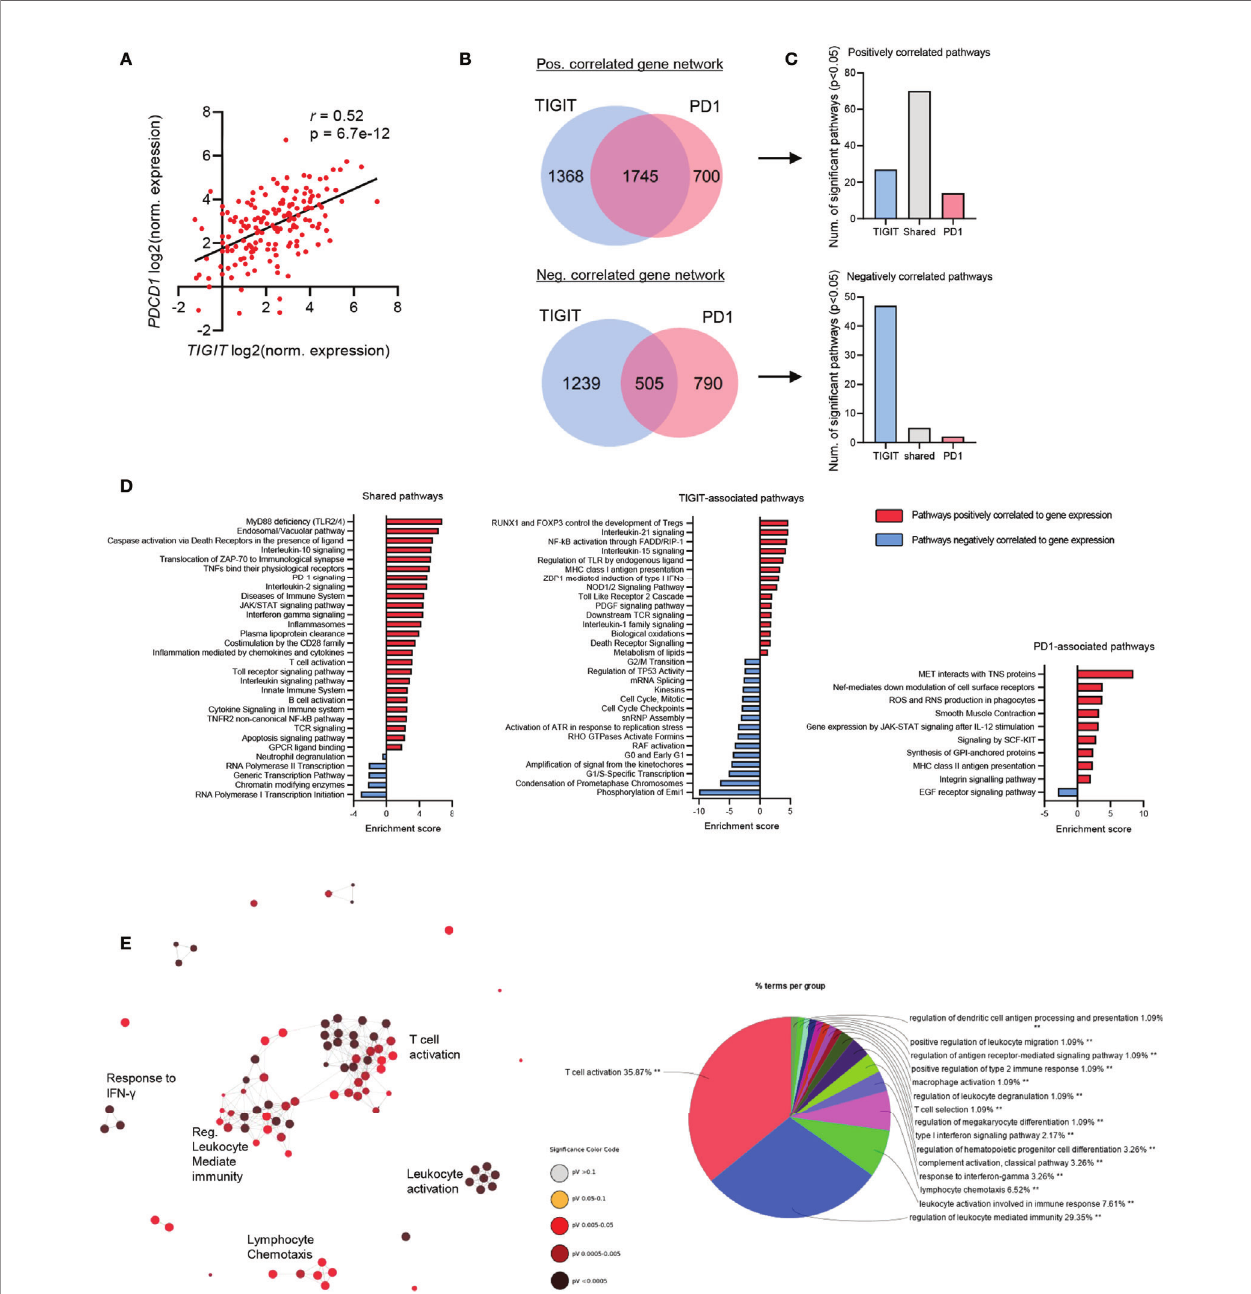
FIGURE 3 | TIGIT and PDCD1 (PD1) exhibit shared immunological networks but have unique regulatory pathways in GBM. GBM patients ’ RNA-seq data was obtained from TCGA, transcript per million (TPM) normalized reads were calculated per each patient and Pearson ’ s correlation analysis was performed. n=153. Genes with a statistically signi fi cant (p<0.05 and FDR<0.05) positive correlation and negative correlation to TIGIT and PDCD1 expression were identi fi ed. (A) Pearson ’ s correlation analysis of TIGIT and PDCD1 expression. (B) Venn diagrams showing number of statistically signi fi cant correlated genes unique and overlapping within TIGIT and PD1 gene groups. (C) Number of statistically signi fi cant (p<0.05 and FDR<0.05) pathway enriched in each corresponding gene group. (D) Representative pathways which are positively and negatively enriched in the shared-gene group, TIGIT-associated group, and PD1-associated group. (E) Network analysis for Gene Ontology (GO) Immunological Processes associated with TIGIT and PDCD1 positively correlated gene network. Statistically signi fi cant gene correlation and pathway enrichments were corrected for false discovery rate (FDR) using Benjamini-Hochberg